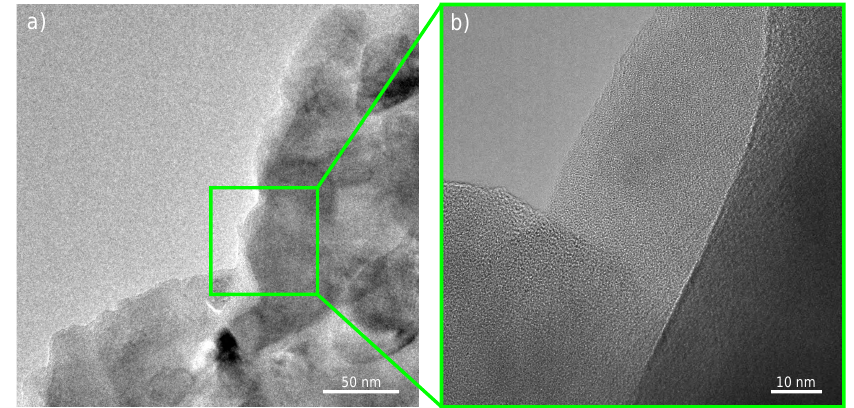
Figure A16. TEM images for CNTN at ( a ) low magnification and ( b ) high magnification. Figures A17 and A18 give the TEM images of planar FLG and ExG, respectively. FLG Avan2 has a less graphene layers compared to ExG.